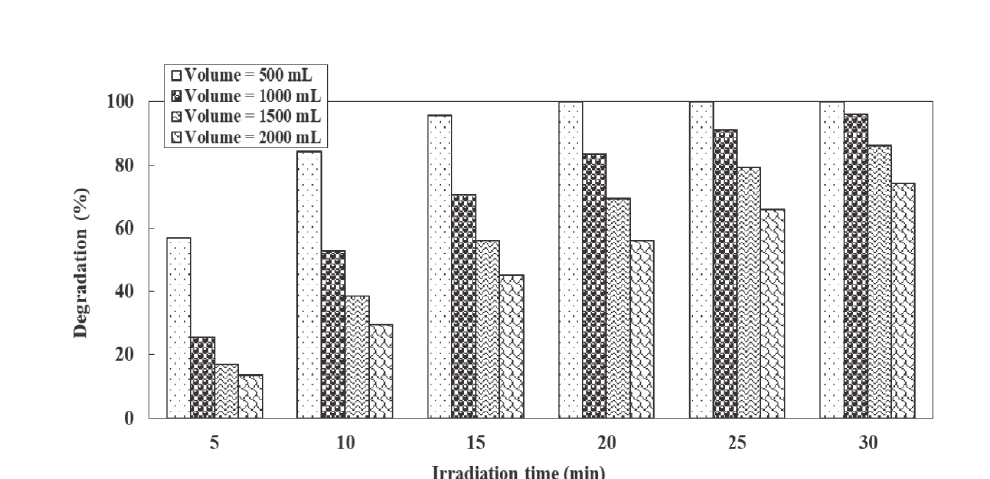
Fig. 5 – Effect of the fluid volume on the removal percent of PNP in the SDP. [PNP] = 20 mg L –1 , pH = 5.5, [H rotation speed = 300 rpm, light intensity = 33 W m –2 , distance between lamps = 3.5